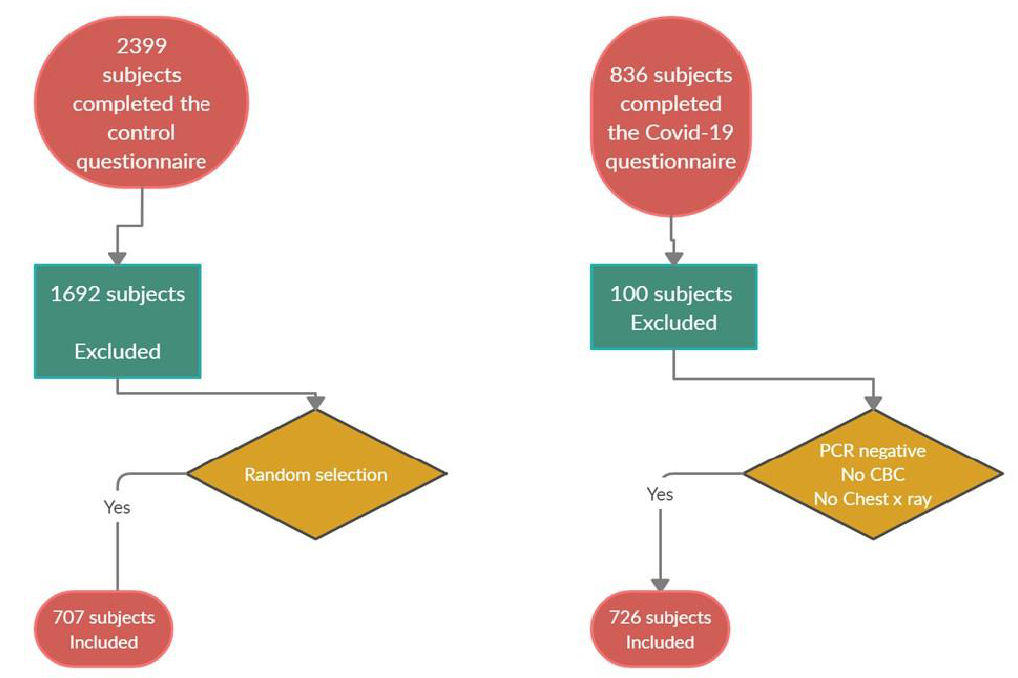
Figure 1. Flowchart for the Covid-19 and control questionnaires.